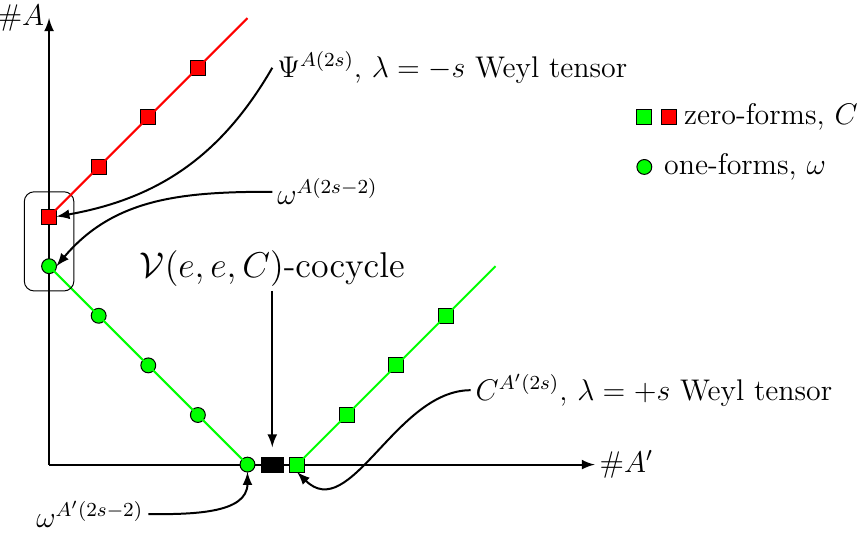
Figure 1 . A diagram to show fields/coordinates involved into the description of higher spin fields. Along the axes we have the number of unprimed/primed indices on a spin-tensor. Degree-one coordinates are circles, degree-zero ones are rectangles. The fields that describe a helicity λ = + s state are green. Those needed to describe helicity λ = − s state are red. The black square shows a cocycle that links the one-form sector to zero-forms (at the free level it relates two fields for each spin’s subsystem). The two fields in the rounded rectangle enter the free action. The rest of the fields encode derivatives thereof in a coordinate invariant and background independent way. The solid lines link pairwise the fields that ‘talk’ to each other in the free